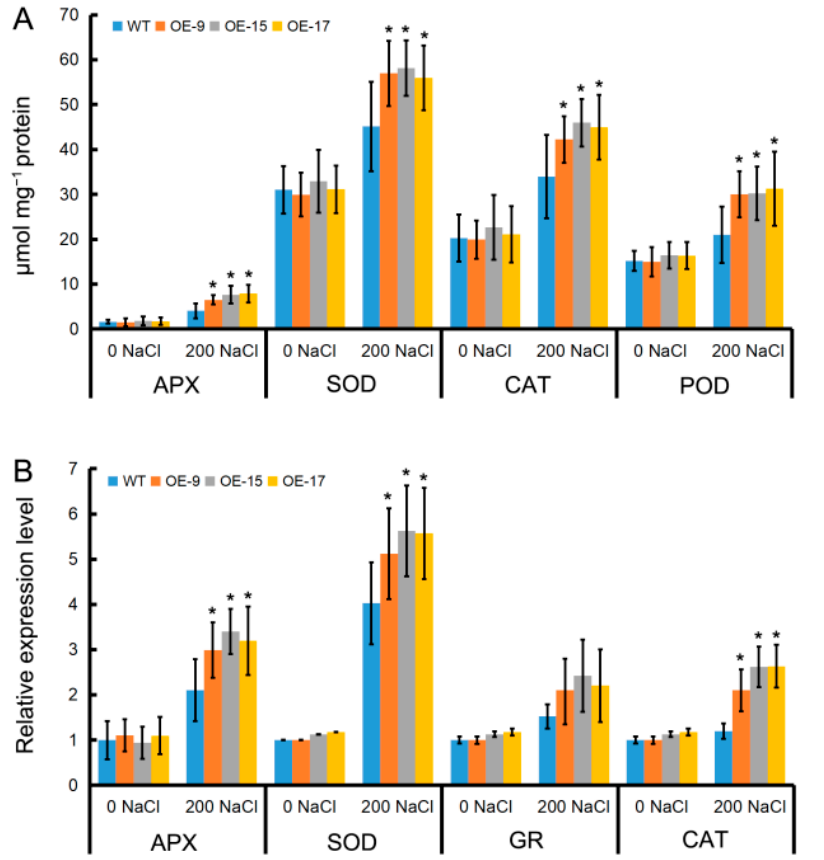
Figure 5. The effect of LjPLT3 on the ROS scavenging mechanism after salt treatment. ( A ) The activities of the antioxidant enzymes after 200 mM NaCl treatment. ( B ) Expression levels of genes encoding ROS scavenging enzymes after NaCl treatment. The expression of LjAPX, LjSOD, LjGR, and LjCAT was calculated relative to that of LjACTIN and the expression in the wild type without NaCl treatment was set to 1. Three-week-old seedlings were treated with 200 mM NaCl and leaves were collected for the analysis of the enzyme activity and gene expression 6 days after 200 mM NaCl treatment. Error bars represent the SD of 5–6 biological replicates. The significant differences were assessed using one-way ANOVA (*, p < 0.05).